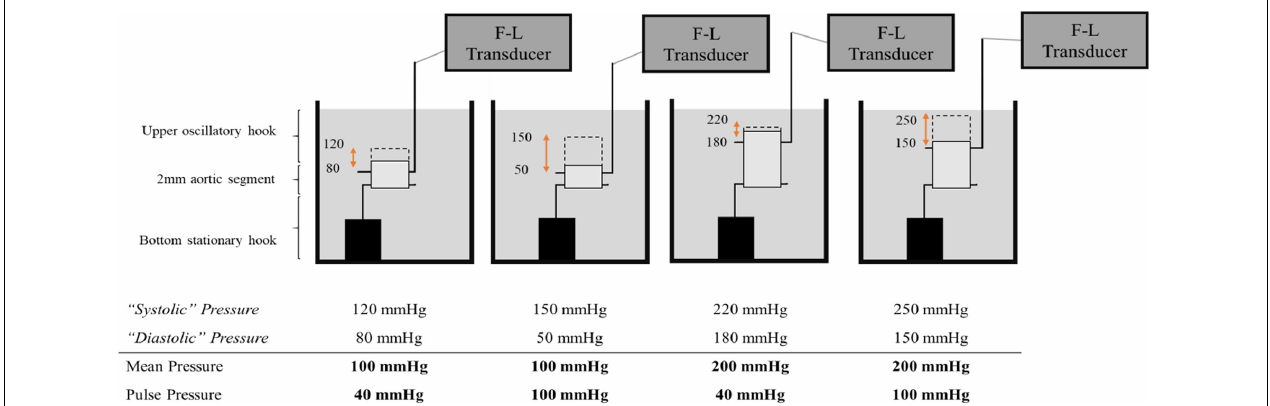
FIGURE 1 | Altering pulsatile load ex vivo . To increase the pulse pressure at equal mean pressure, the diastolic and systolic pressures are decreased and increased, respectively, with equal increments. A segment that oscillates between 80 mmHg diastolic pressure and 120 mmHg systolic pressure, is exposed to a mean pressure of 100 mmHg and a pulse pressure of 40 mmHg. Alternatively, a segment that oscillates between 50 mmHg diastolic pressure and 150 mmHg systolic pressure, is exposed to an equal mean pressure of 100 mmHg but an increased pulse pressure of 100 mmHg. F-L Transducer = Force-Length